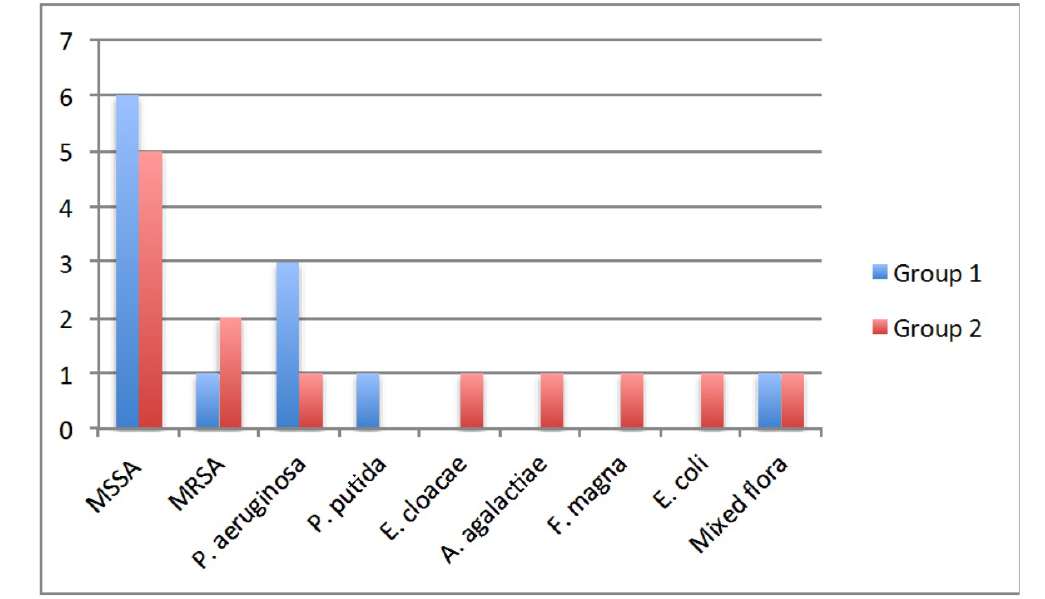
Figure 1. Microorganisms isolated in the two different treatment